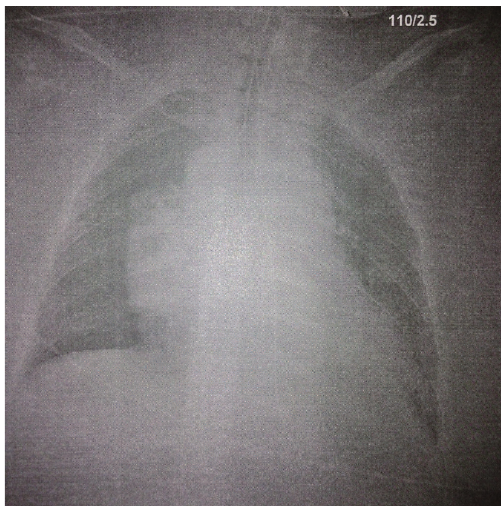
Figure 1: Chest X-ray showing large mediastinal